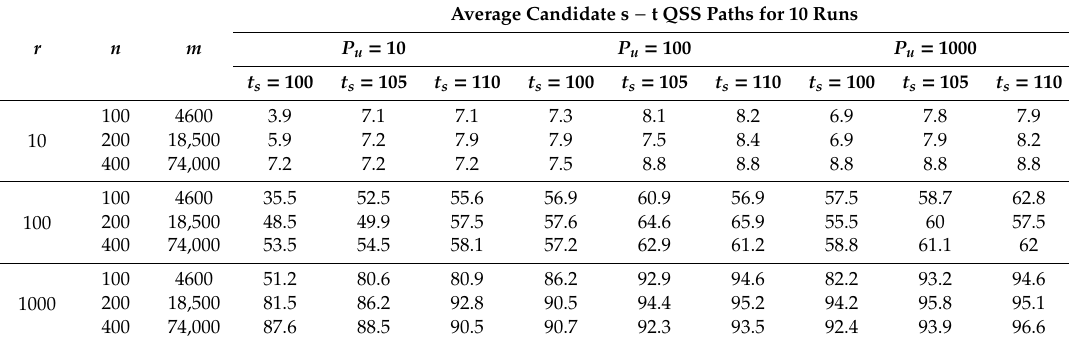
Table 11. Average candidate s − t QSS paths for the SESE algorithm for 10 Mb .